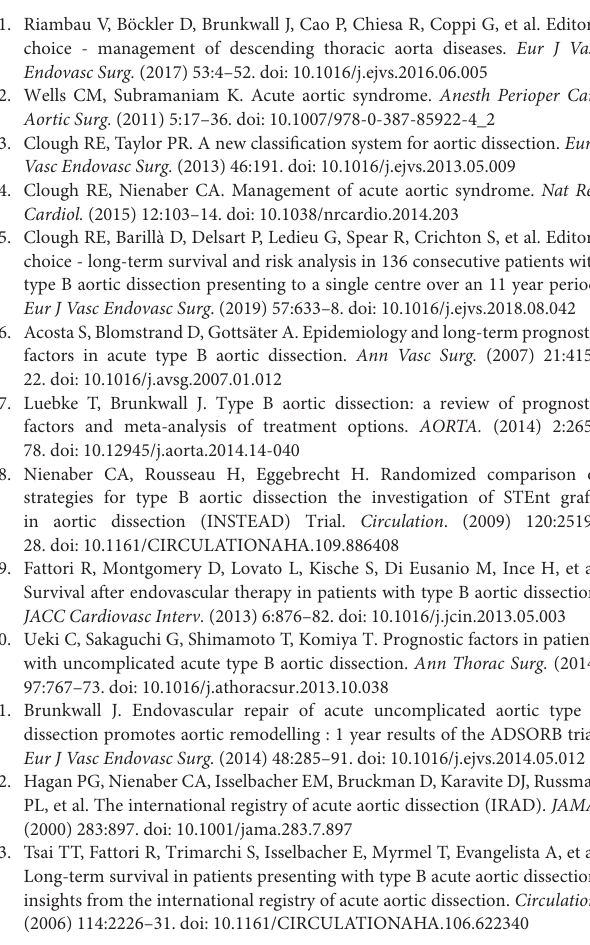
Supplementary Figure 2 | Distribution of the number and size of intimal tears, the distance from the first intimal tear to the left subclavian artery (LSA), the relative